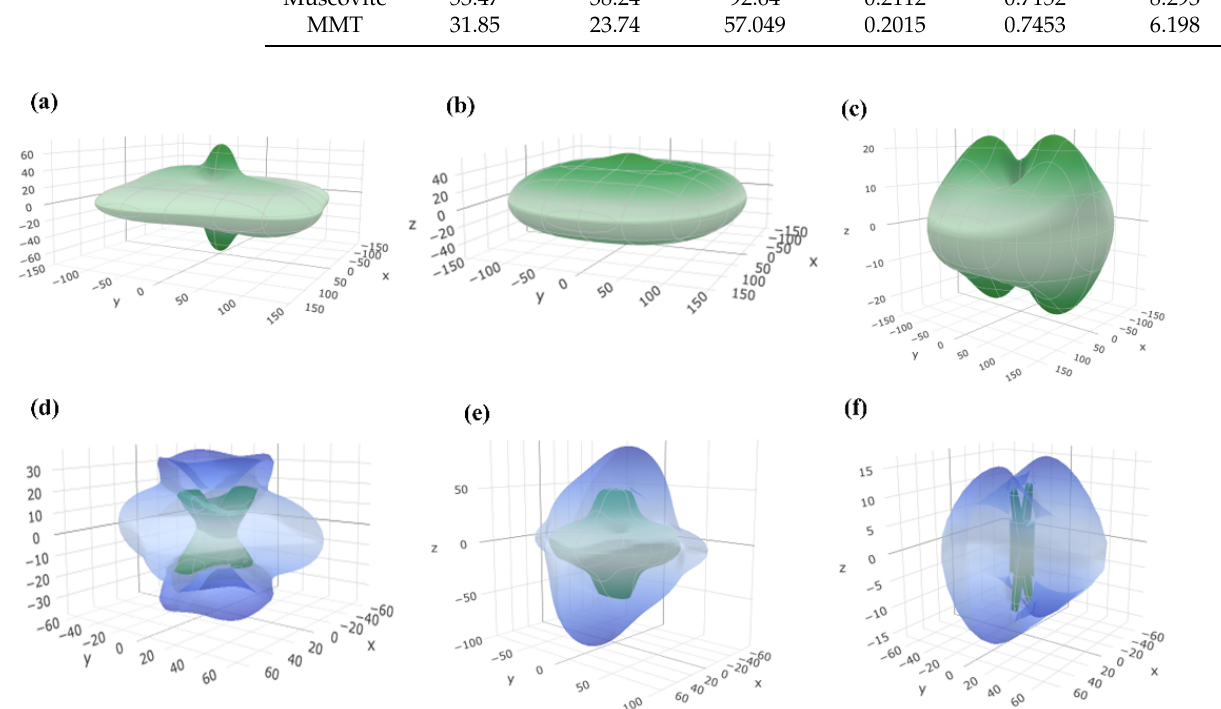
Figure 7. A 3D representation surfaces of Young’s modulus for ( a ) kaolinite, ( b ) muscovite, and ( c ) montmorillonite. ( d – f ) show the shear modulus for kaolinite, muscovite, and montmorillonite crystals, respectively. Green: minimum positive, translucent blue: maximum positive [36].